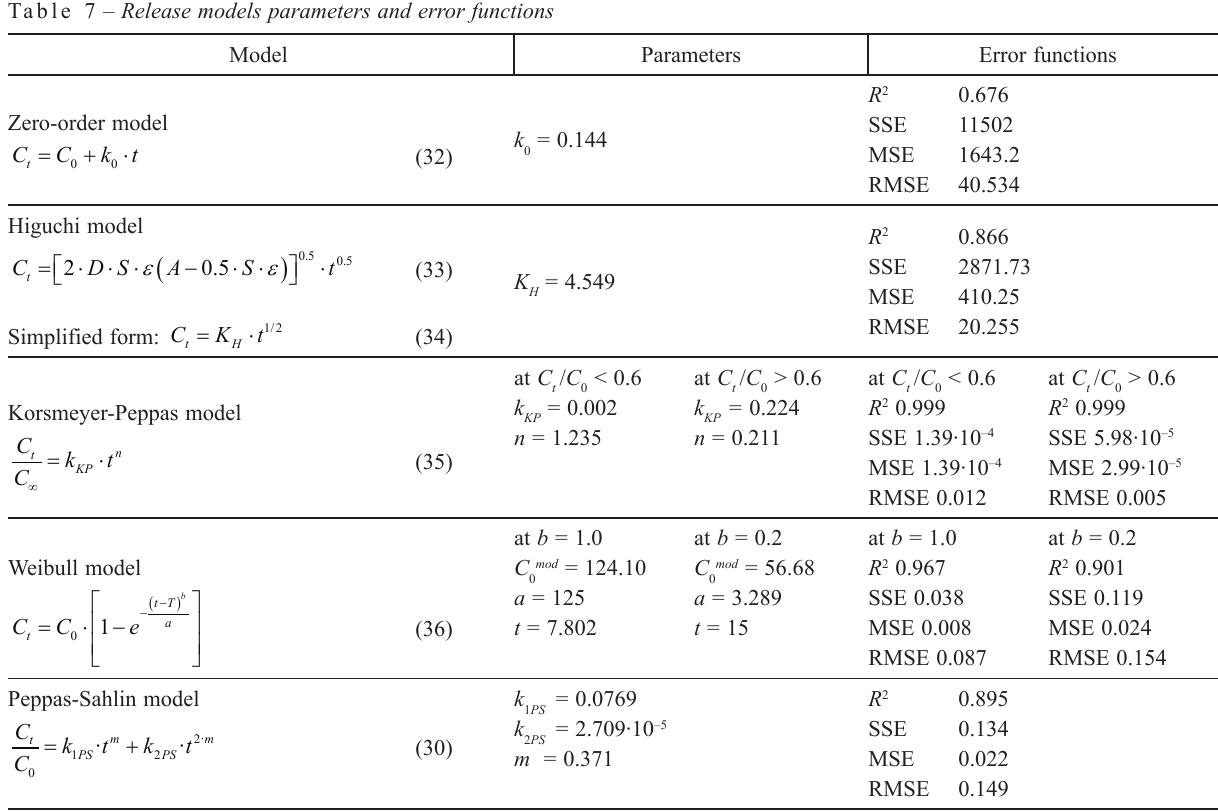
Table 7 – Release models parameters and error functions Model Parameters Error